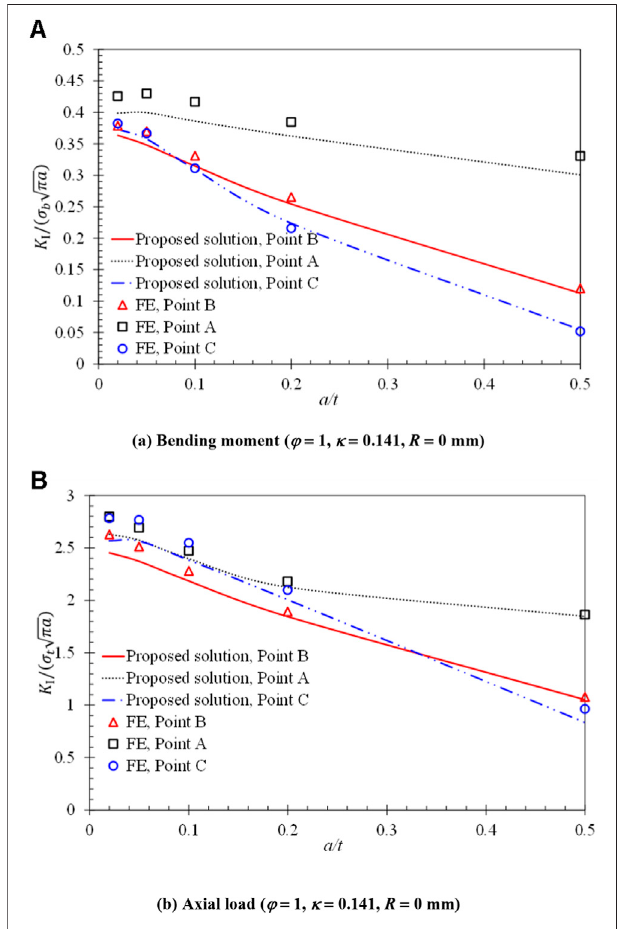
FIGURE 12 | Comparison of SIF results under different